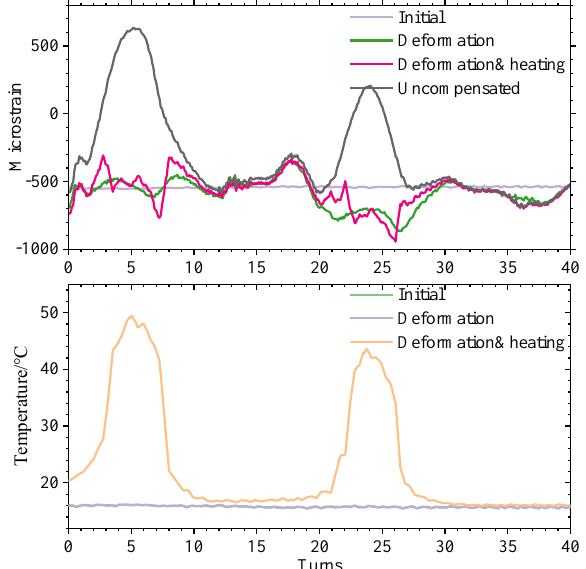
Figure 13. Schematic diagram of temperature compensation. Table 5. Comparison of deformation and heat-up test